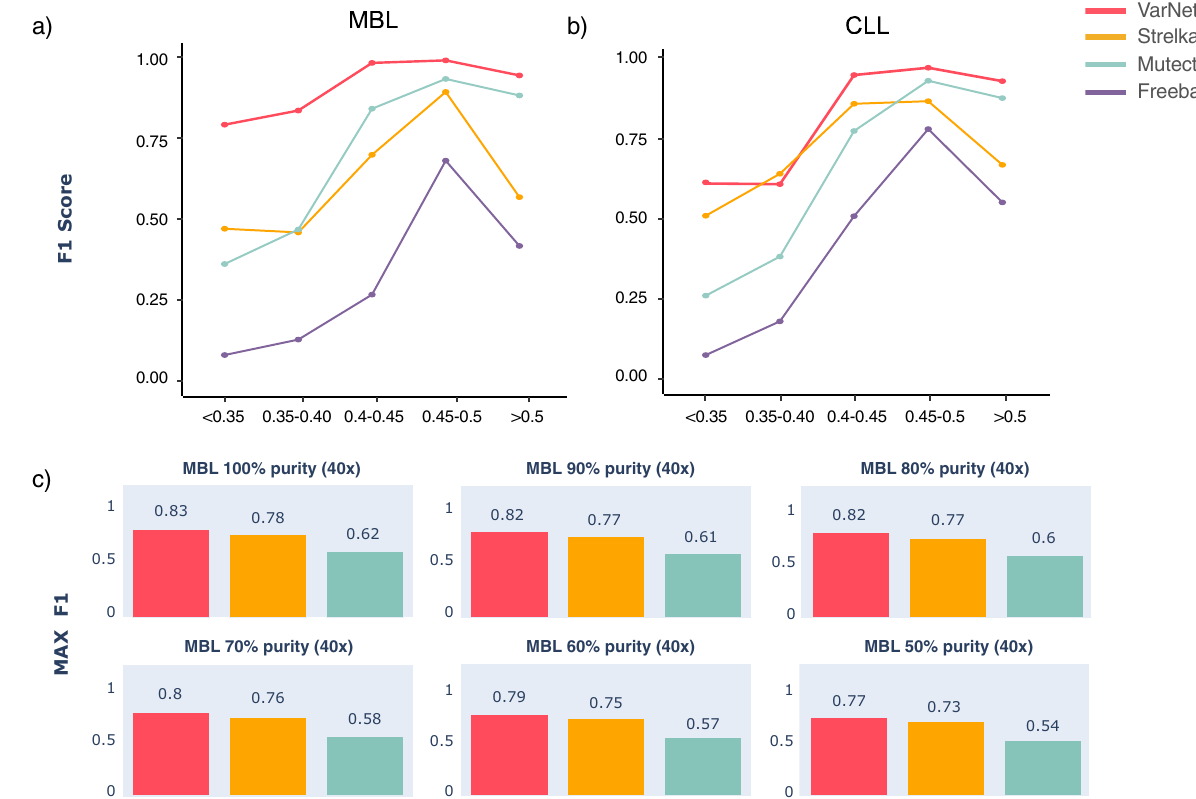
Fig. 4 Impact of VAF and tumor purity levels. a , b SNV calling at VAF level bins in the MBL/CLL tumors. c SNV calling on MBL downsampled to 40×- depth and “ contaminated ” with normal reads to simulate purity levels. Purity levels are relative to the original purity of the MBL tumor (>95%). Source data are provided as a Source Data fi